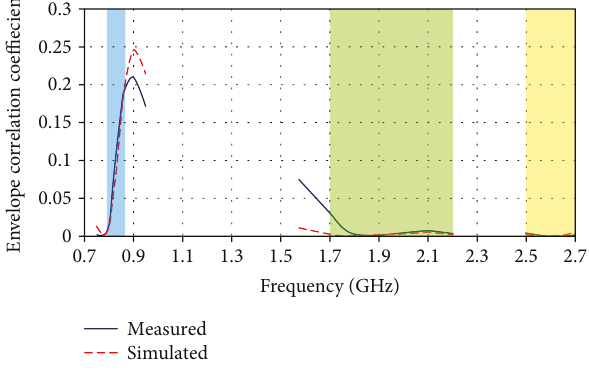
Figure 22: ECC value of the MIMO